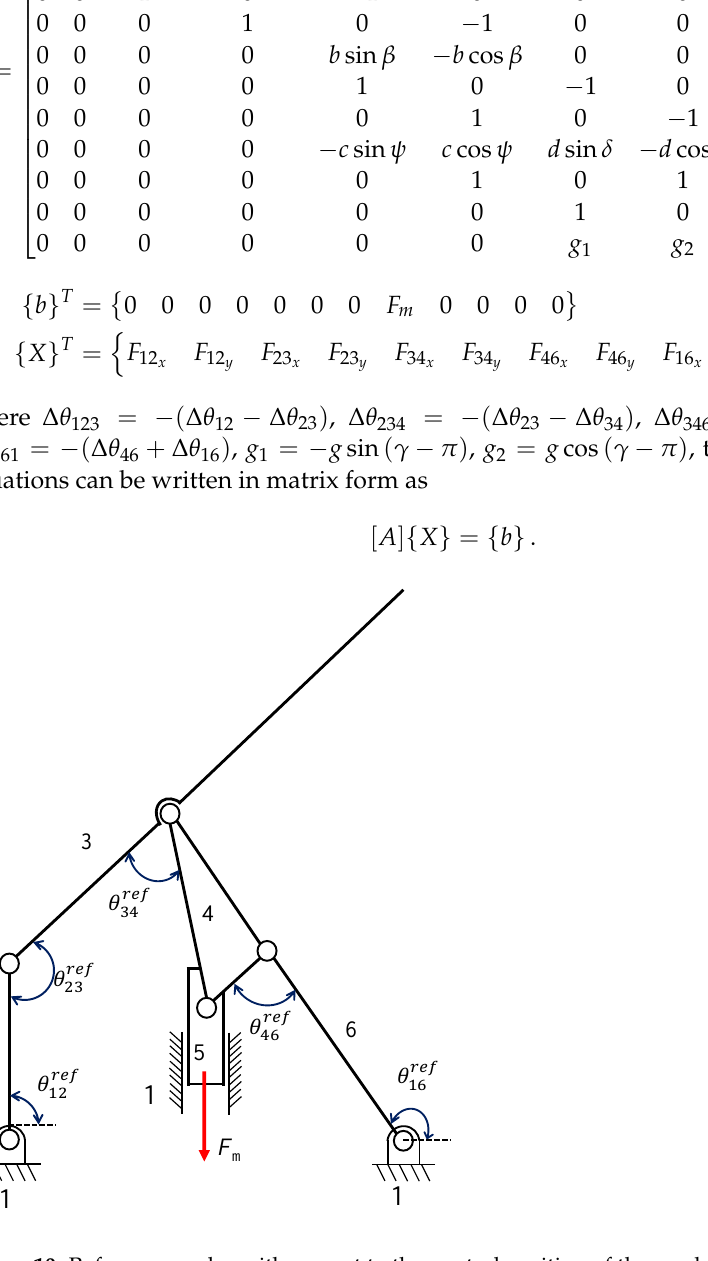
Figure 10. Reference angles with respect to the neutral position of the